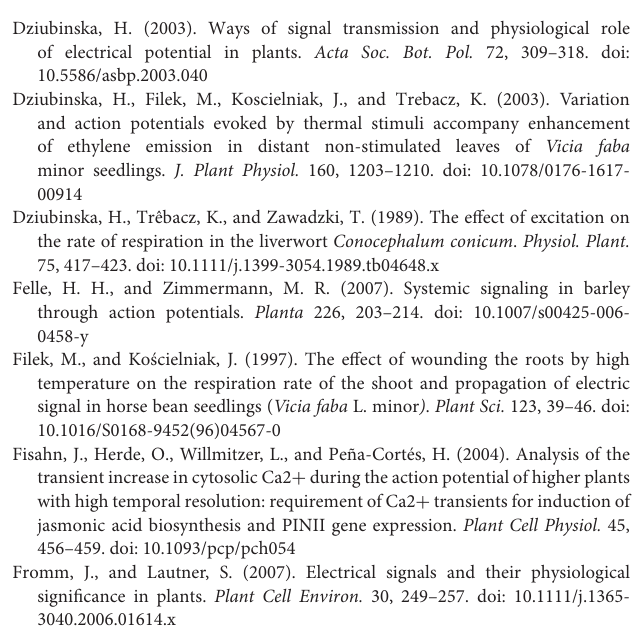
( Figure 3C , Table 1 ) supports a decrease of luminal pH because lumen acidification is known to increase NPQ (Ruban et al., 1993; Maxwell and Johnson, 2000; Müller et al., 2001; a decrease of H + -ATP synthase activity (a decrease of